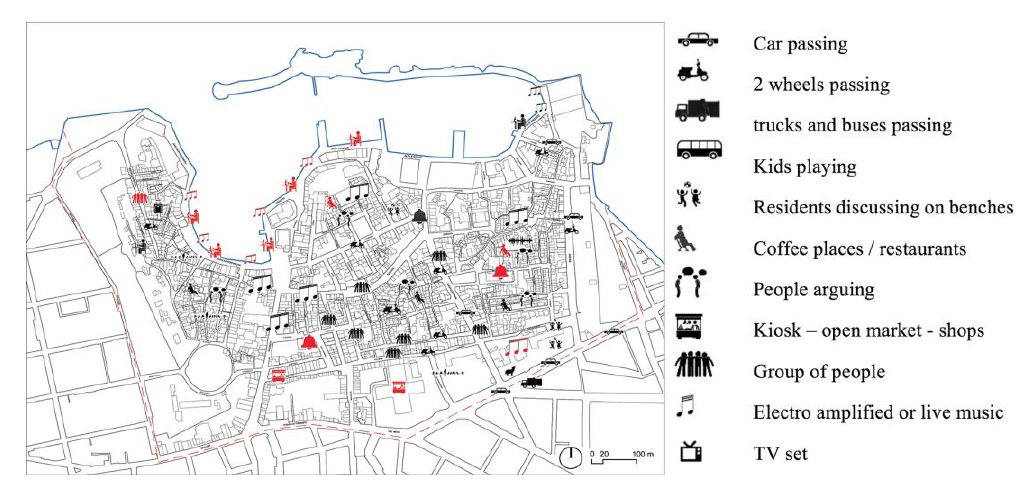
Figure 11. Sound signals and sound marks map.